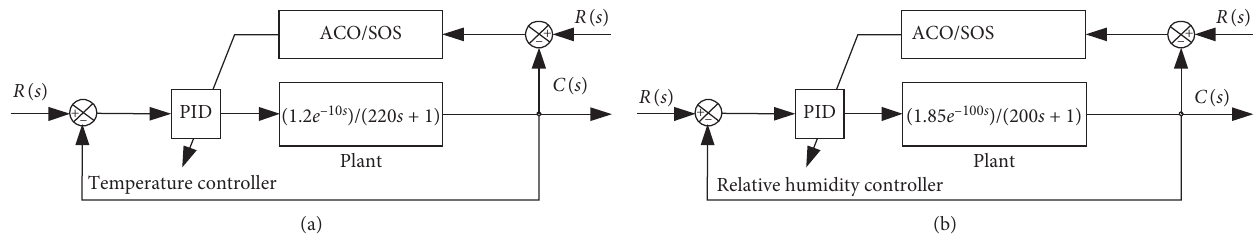
Figure 12: Block diagram PID controller by the ACO and SOS methods. (a) Temperature plant. (b) RH plant.